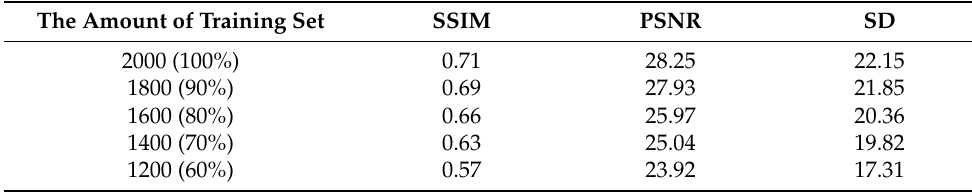
Table 10. Minimum training data experimental results.